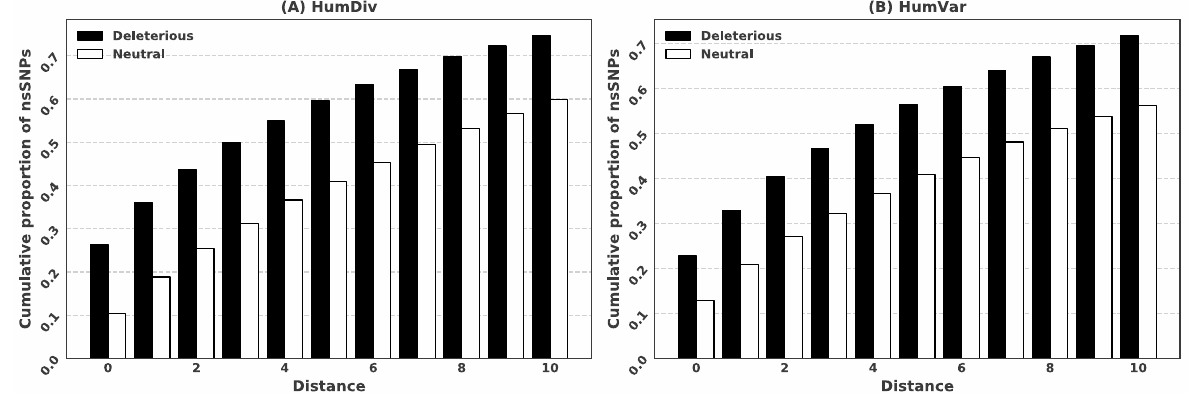
Figure 2. Cumulative proportion of the predicted ligand-binding positions for the deleterious and neutral nsSNPs. The distance is the linear distance (along the sequence) between a given nsSNP position and the position of the closest predicted binding residue.